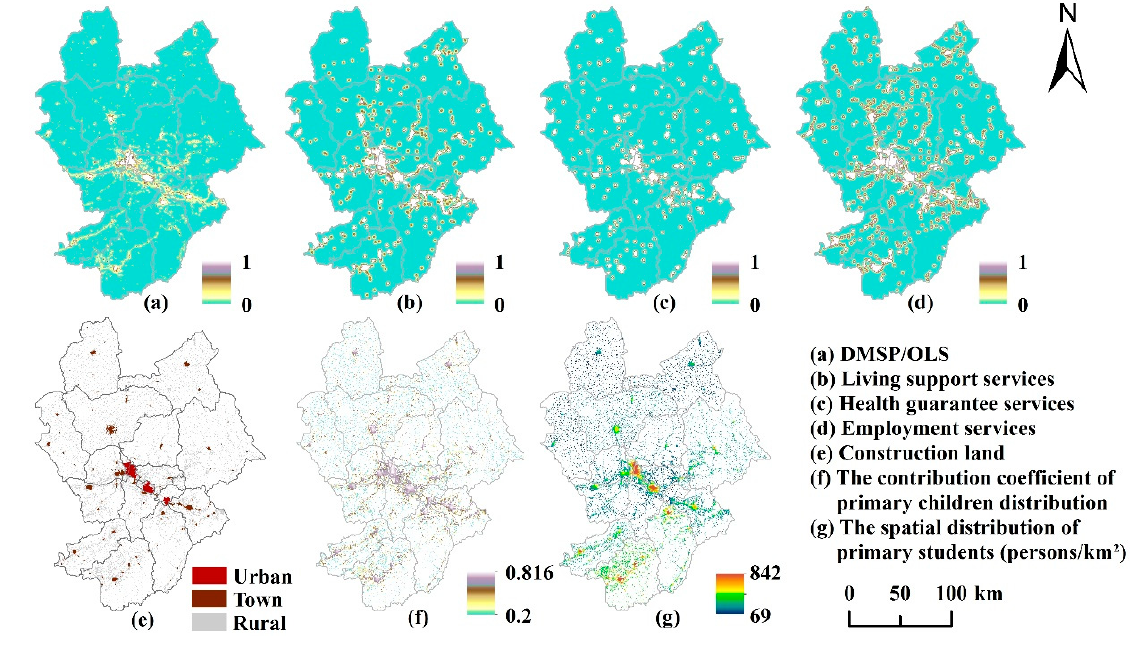
Figure 3. Maps to show the spatial distribution of primary students in this analysis.